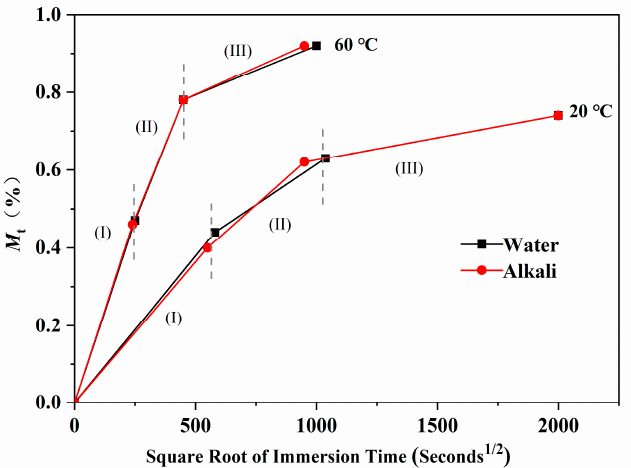
Figure 5. Water uptake characteristics of epoxy resin specimens immersed in distilled water or the alkali solution at 20 °C and 60 °C.